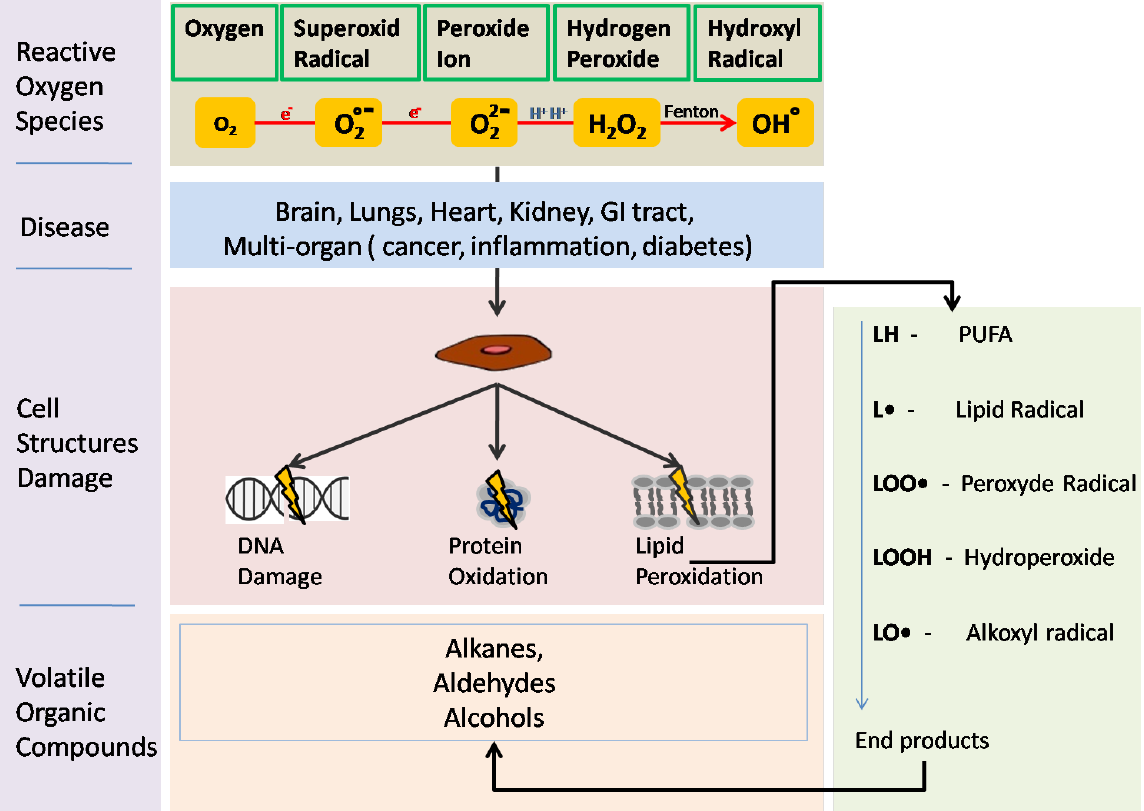
Figure 1: Interplay between VOCs – OS in local and systemic